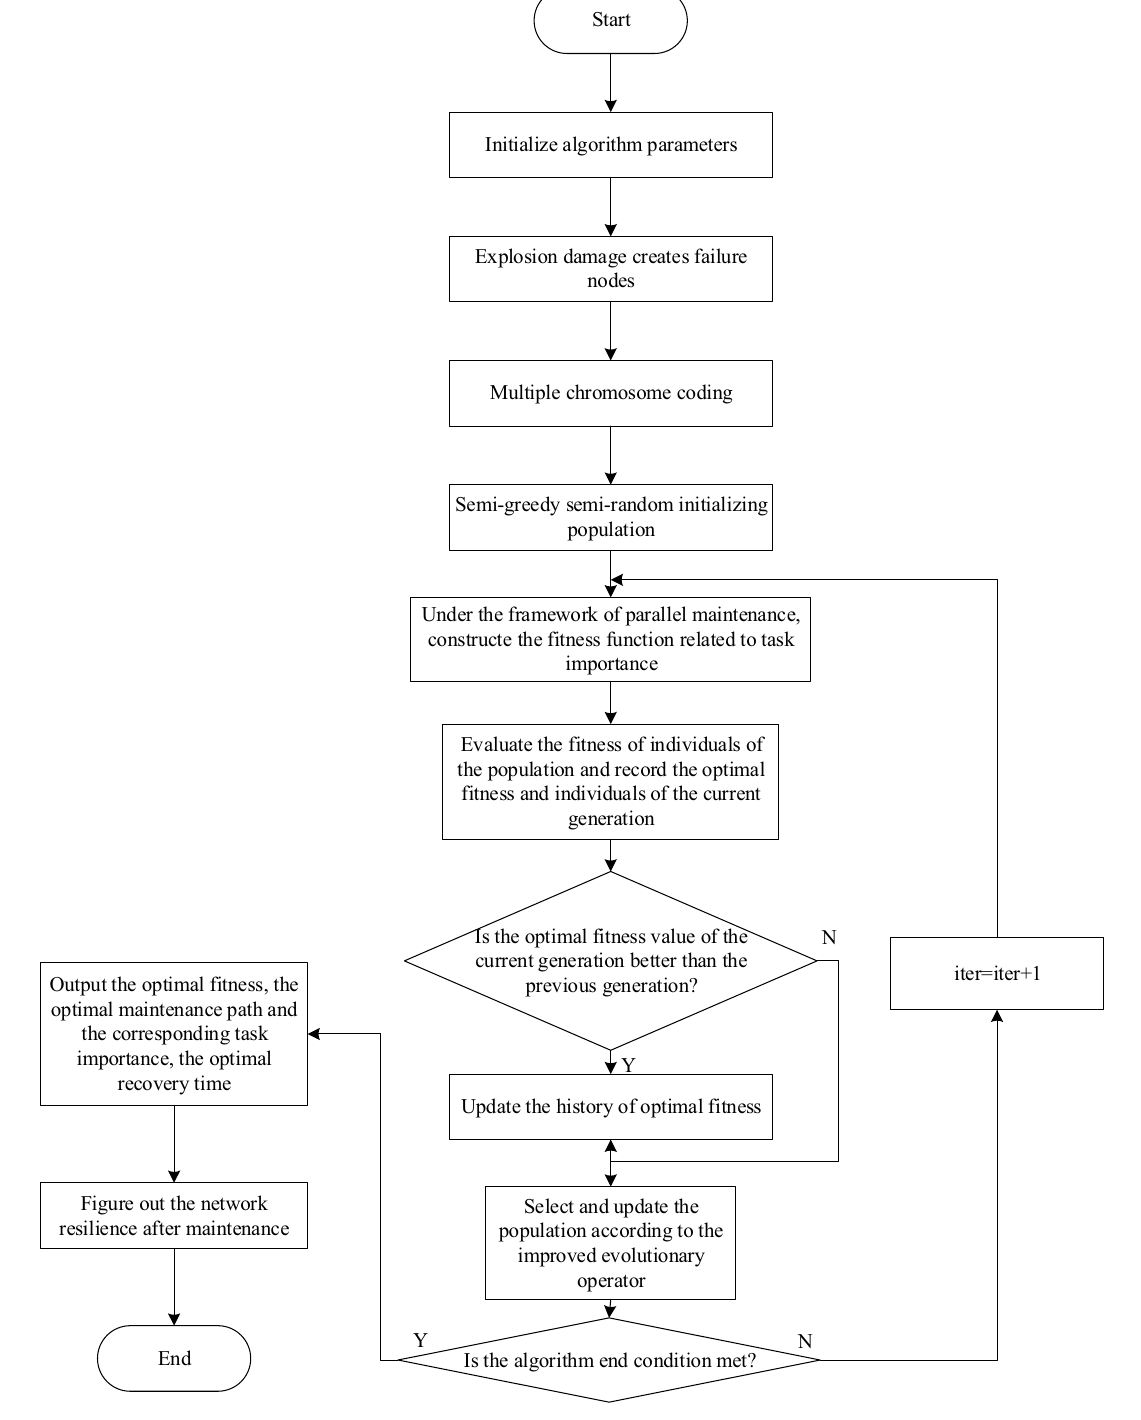
Fig. 4 Implementation of improved genetic (10) The termination condition of the algorithm adopts the method of the maximum number of iterations set to 500. (11) After the task importance of all normal nodes and recovery time are known, the network resilience R